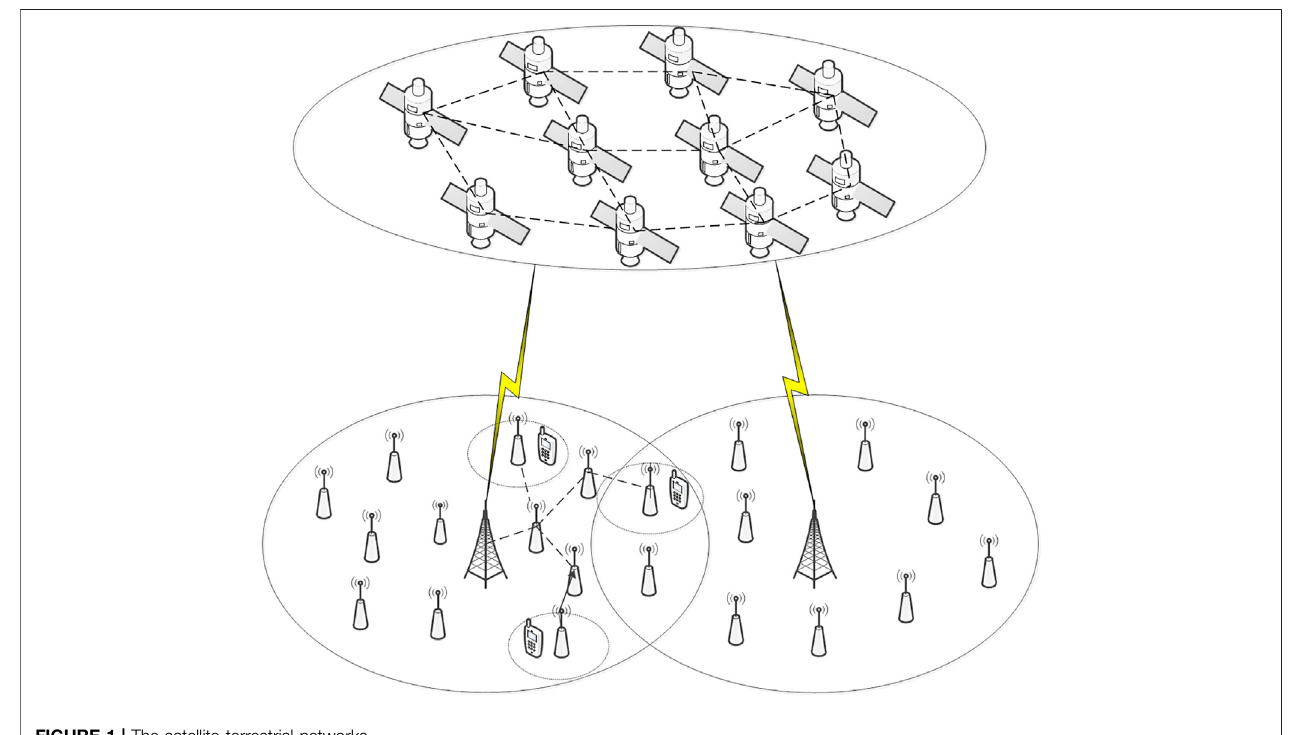
FIGURE 1 | The satellite-terrestrial networks.